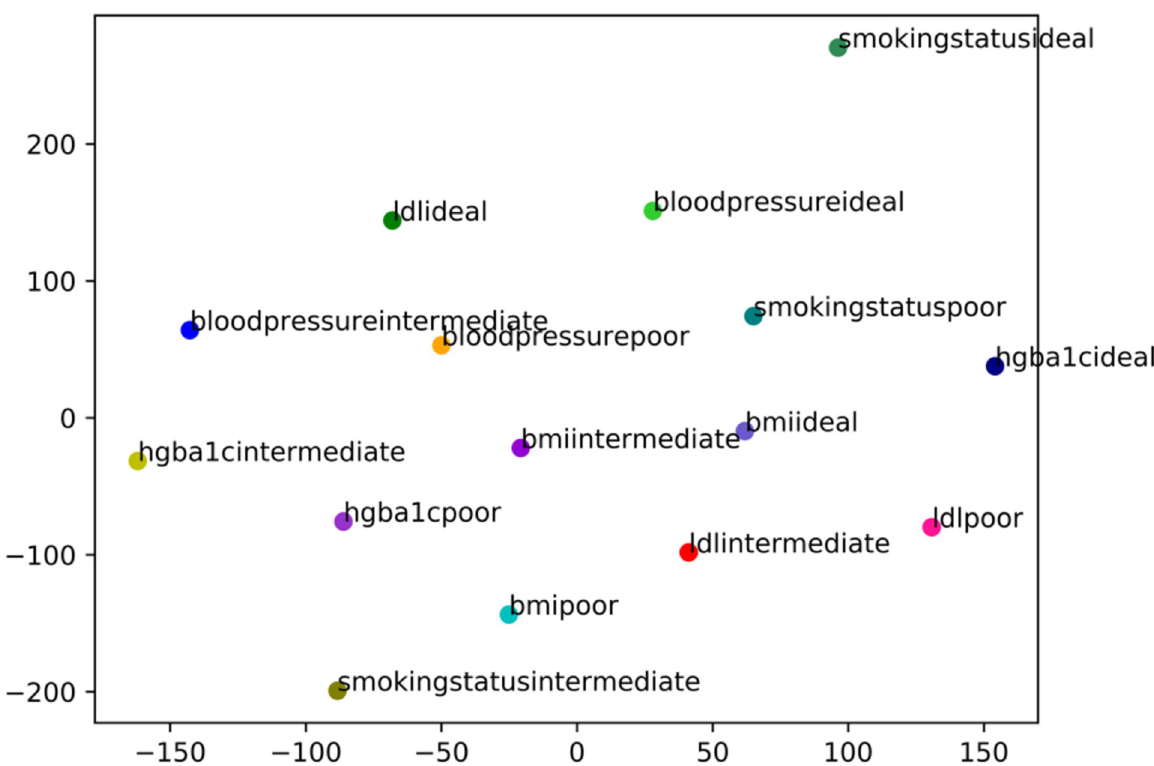
Fig 3. Embedding visualization of the combination of measure submetric and measure values. X and y-axes are the first two components in the t-Distributed Stochastic Neighbor Embedding (tSNE).